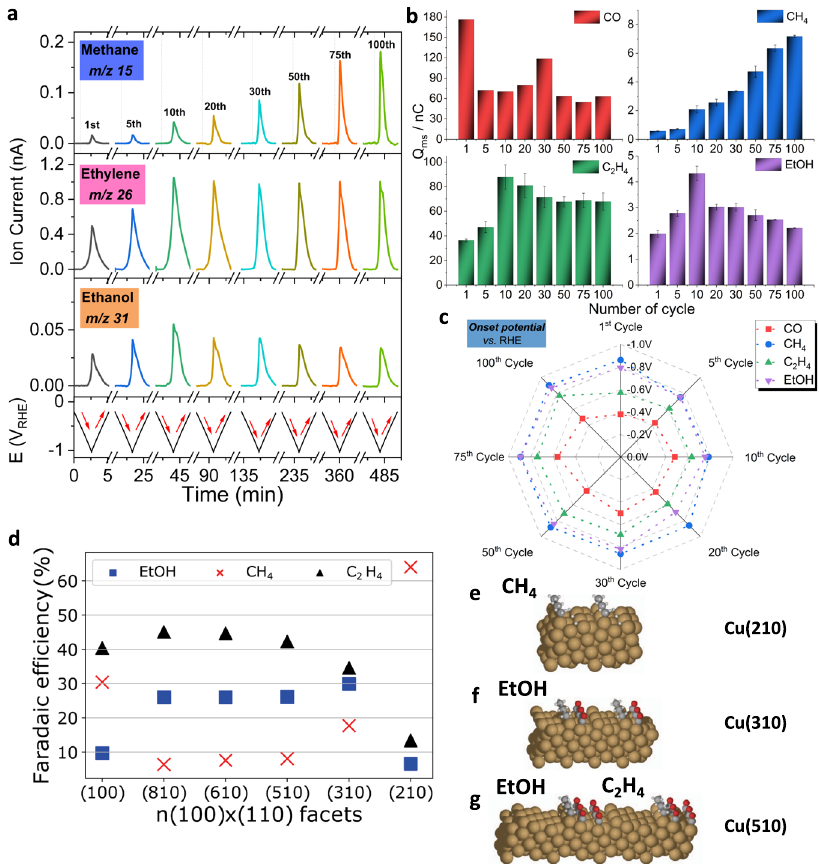
Fig. 5 Products formation and onset potential shift along the electroreduction of CuO NS catalyst. a Operando differential electrochemical mass spectrometry (DEMS) sweep data obtained during CO2RR on CuO NS catalysts (supported on a fl at 0.785 cm 2 glassy carbon electrode, catalyst loading: 100 μ g cm − 2 .) using CO 2 -saturated 0.1 M KHCO 3 by continuous cyclic voltammetric scan at 5 mV s − 1 . b DEMS-derived mass charges for various products formed during the cathodic and anodic voltammetric sweep. The error bars are given as standard error of mean. c Spider plot shows the variations in the onset electrode potential of key products during CO2RR by continuous cyclic voltammetric scan at 5 mV s − 1 (see Supplementary Table S2). Product molecules considered are: m/z = 28 CO, m/z = 15 corresponding to methane, m/z = 26 corresponding to ethylene, m/z = 31 corresponding to ethanol. d Faradaic ef fi ciencies of CH 4 , EtOH and C 2 H 4 on Cu(100) terraces of (from left to right) shrinking width and increasing density of Cu(110) steps. While Cu (100) shows little EtOH, EtOH increases with larger (110) step density and narrower (100) terrace width, peaking at Cu(310). The narrow (100) terraces on Cu(210) prevent EtOH formation in favor of CH 4 (data from Ref. 56 ). e – g Illustration of *CH 3 as common intermediate of CH 4 and EtOH: Side views of the Cu(210), Cu(310) and Cu(510) single crystal facets. Cu(210) features exclusive *CH 3 and *H adsorption toward CH 4 , while Cu(310) allows for C-C coupling between *CH 3 and carbonaceous adsorbates on the (100) terraces toward EtOH. The wider (100) terraces of Cu(510) also enables C-C coupling among carbonaceous adsorbates to C 2 H 4 . Grey: C, white: H,